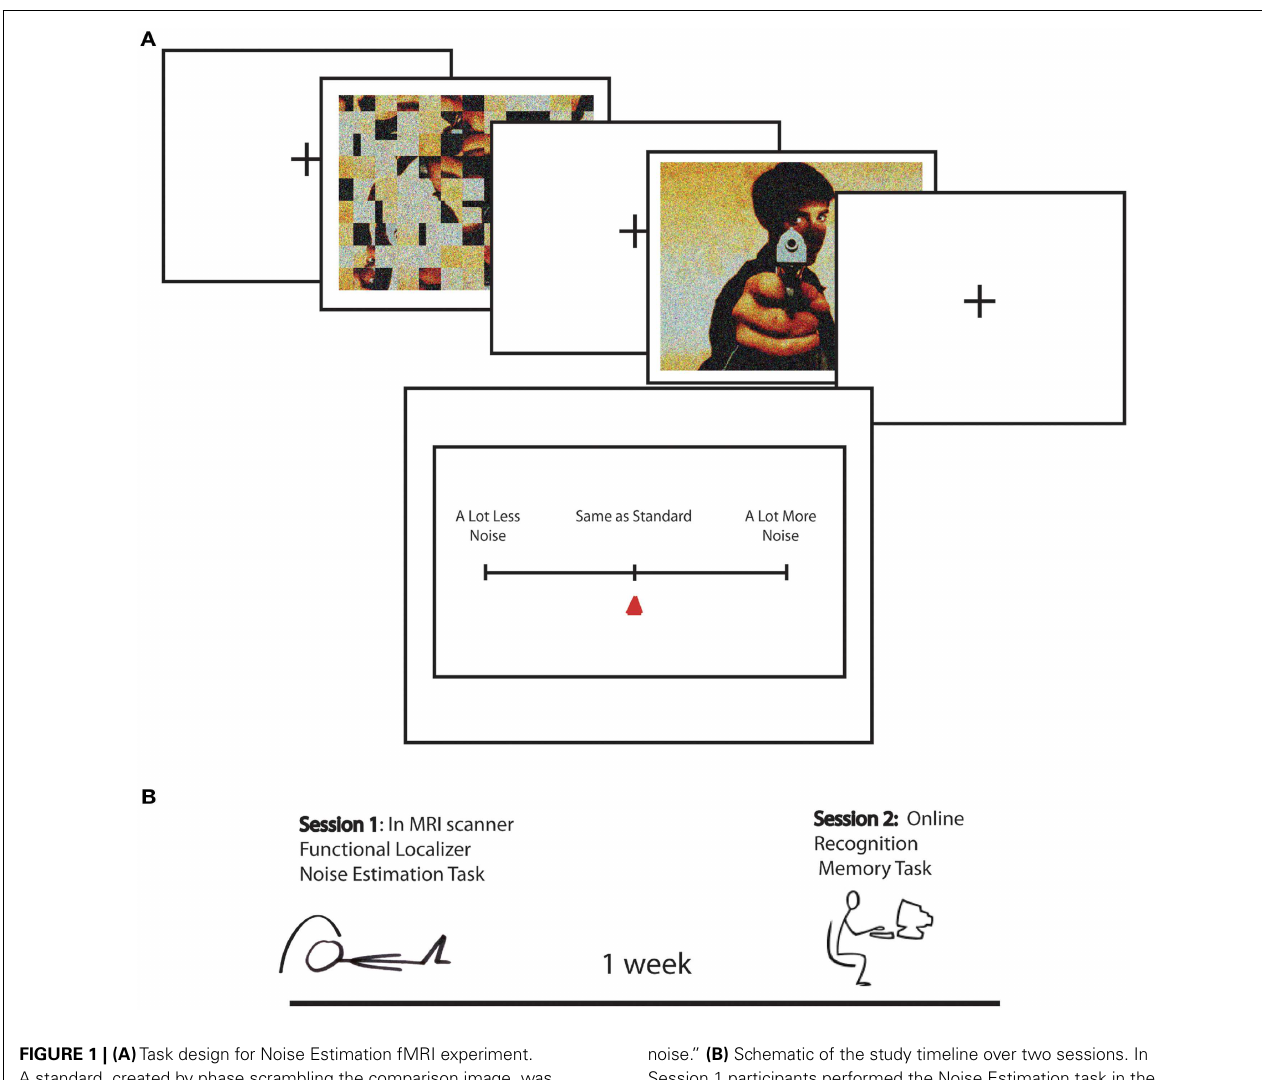
FIGURE 1 | (A) Task design for Noise Estimation fMRI experiment. A standard, created by phase scrambling the comparison image, was overlaid with 15% noise.The standard was followed by the image overlaid with 10, 15, or 20% noise. Following image offset, participants moved a cursor on a scale to indicated NE for the image relative to the standard from “a lot less noise” to “same as standard” to “a lot more